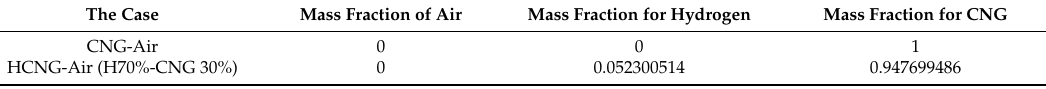
Table 3. Mass fraction settings in ANSYS fluent software according to type of fuel and mixing ratio.